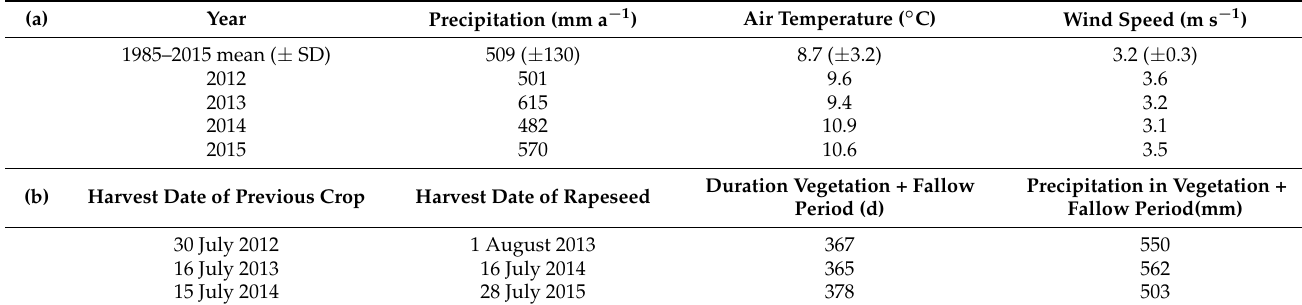
Table 1. Meteorological characteristics of the study site. ( a ) Long-term means (1985–2015) of annual precipitation, air temperature (2 m), and wind speed; and annual values in the experimental years. ( b ) Harvest dates of the winter oilseed rape and precipitation in the vegetation and fallow